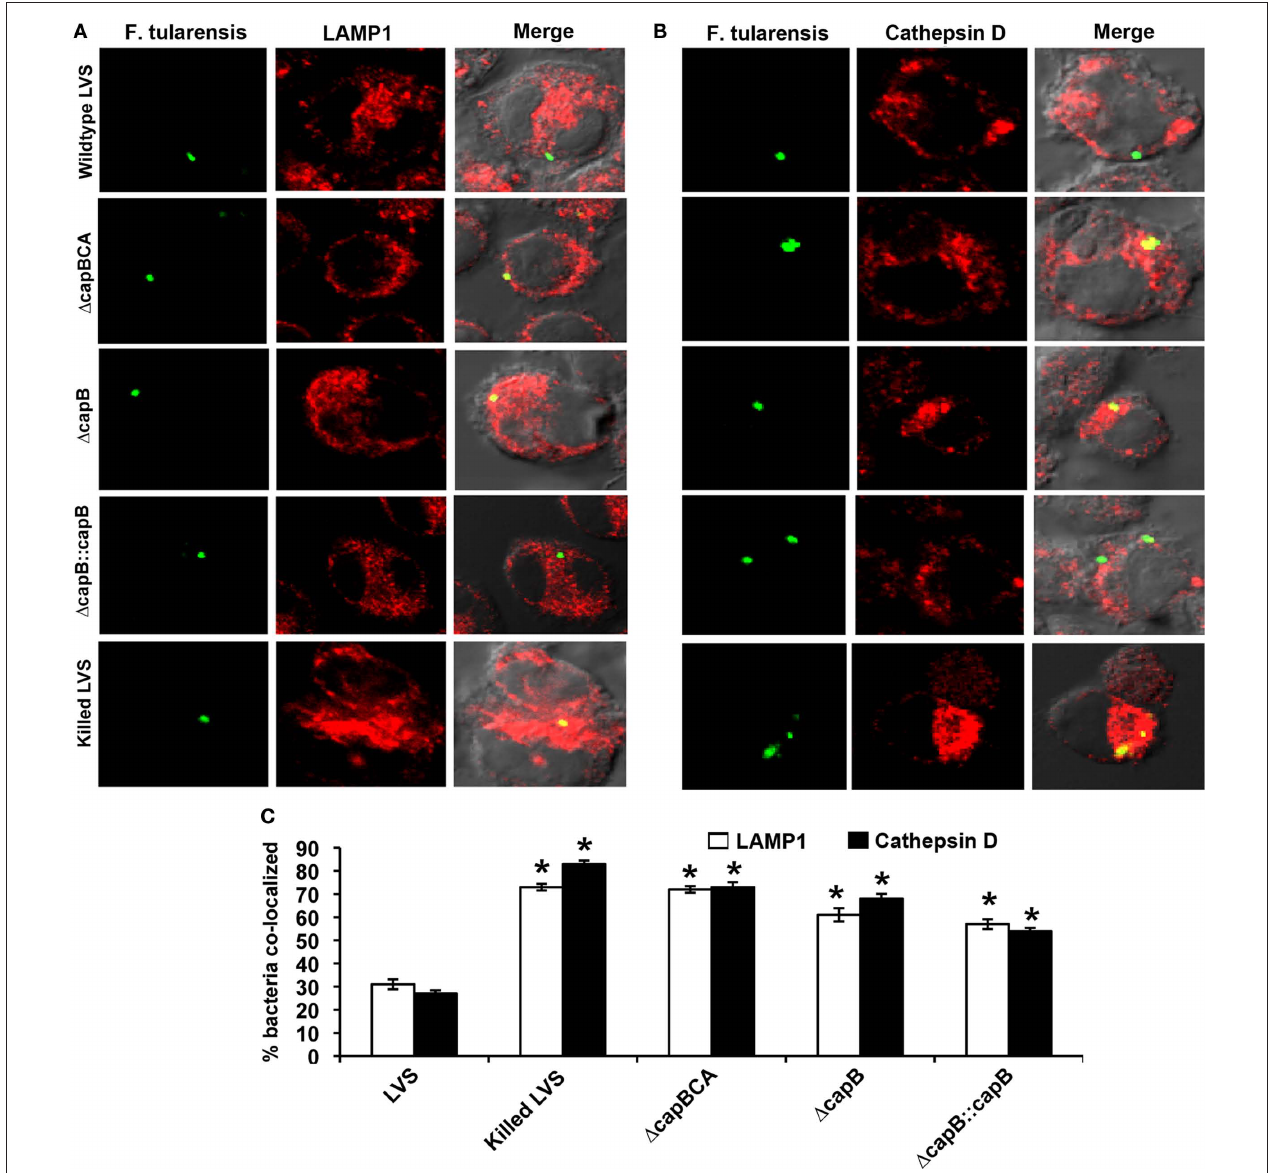
Figure 5 | Co-localization of F. tularensis capBCA mutants with phagosomal and phagolysosomal markers. (A) Representative images showing co-localization of the LVS capBCA mutants with the phagosomal marker LAMP-1. F. tularensis and LAMP-1 were stained and visualized as described in Section “Materials and Methods.” (B) Representative images showing co-localization of the LVS capBCA mutants with phagolysosomal